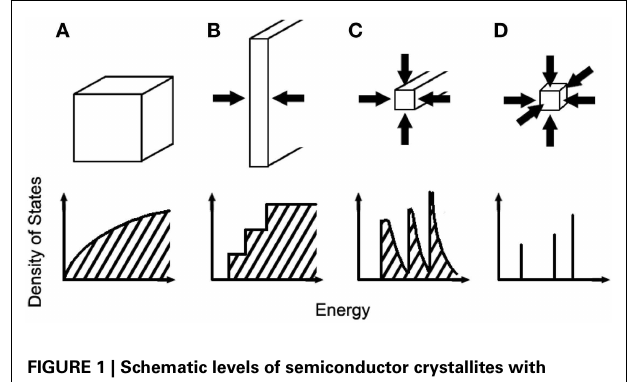
FIGURE 1 | Schematic levels of semiconductor crystallites with different dimensions . (A) Three-dimensional structure,